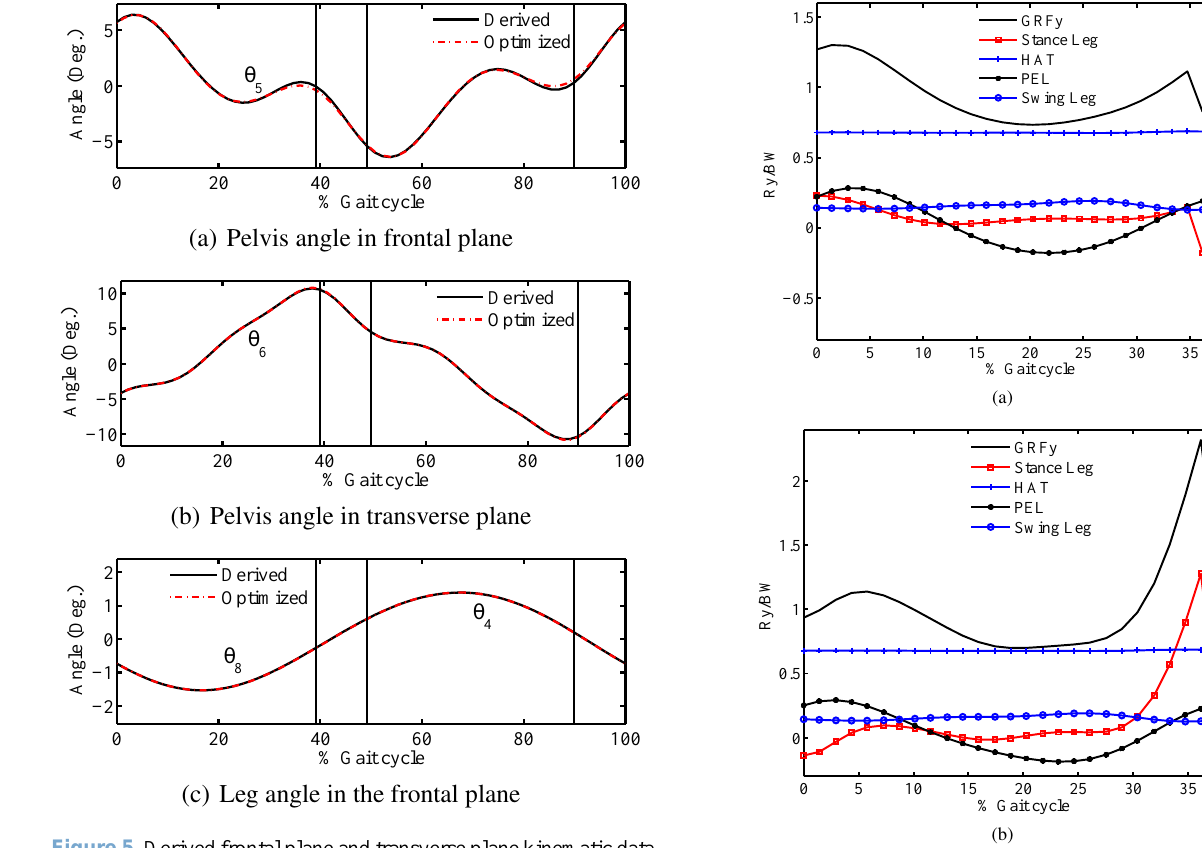
Figure 6. GRFyandstanceleg,HAT,pelvisandswinglegcontribu- Figure 6. GRFy and stance leg, HAT, pelvis and swing leg contribu- tions during SS phase as a fraction of body weight with (a) AFROS tions during SS phase as a fraction of body weight with (a) AFROS and (b) FROS. (Gait cycle starts at toe-o ff of the other leg, that is, at and (b) FROS. (Gait cycle starts at toe-off of the other leg, that is, the beginning of SS.) at the beginning of SS.) of the stance leg and pelvis (Fig. 6). The contributions of the HAT to GRFy are also relatively constant (Fig. 6). The variable acceleration terms ( k i E i s) of R i of the swing leg segments (Eqs. A13 to A15) are rendered negligible by the small values of the corresponding k i s. In the case of the HAT segment, the k i E i of the contribution (Eq. A12) is small due to minimal change in the HAT angle (Fig. 4d, HAT angle has a range of 4 ◦ ). Hence, only the segment weights (that is, the gravity terms in Eqs. A12 to A15) of the HAT and swing leg segments contribute to GRFy. The difference be- tween RMS values (Table 1) with all the DOF and with- out the DOF of the swing leg and HAT is approximately 0.01 BW for GRFy. This difference is negligible given that Mech. Sci. the GRFy varies around 1 BW in the SS phase of normal walking. Therefore, the DOFs of the swing leg and HAT, θ 7 to θ 11 , can be eliminated from the equation for GRFy. The contribution of the transverse plane rotation of the pelvis to GRFy (Eq. 10, Fig. 10) is zero, and the contribution of the frontal plane rotation of the pelvis to GRFy (Eq.